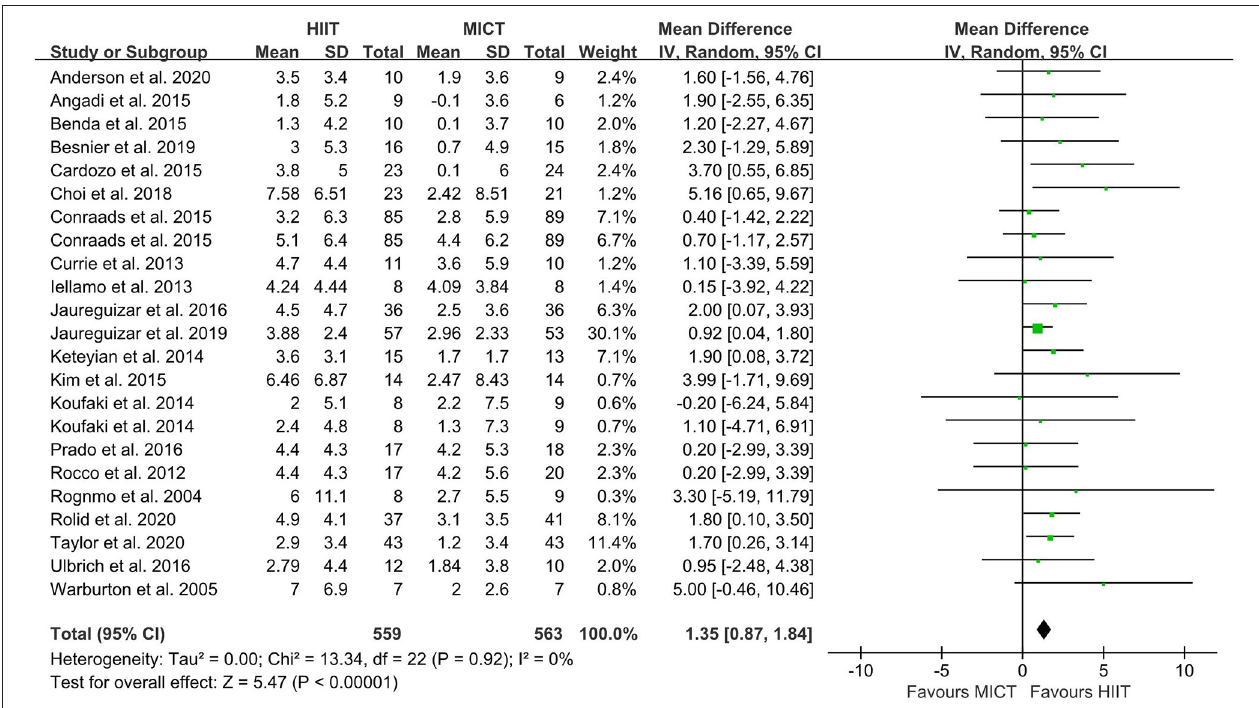
FIGURE 3 | Forest plot depicting cardiorespiratory fitness changes as a HIIT vs. MICT. HIIT, high-intensity interval training; MICT, moderate-intensity continuous